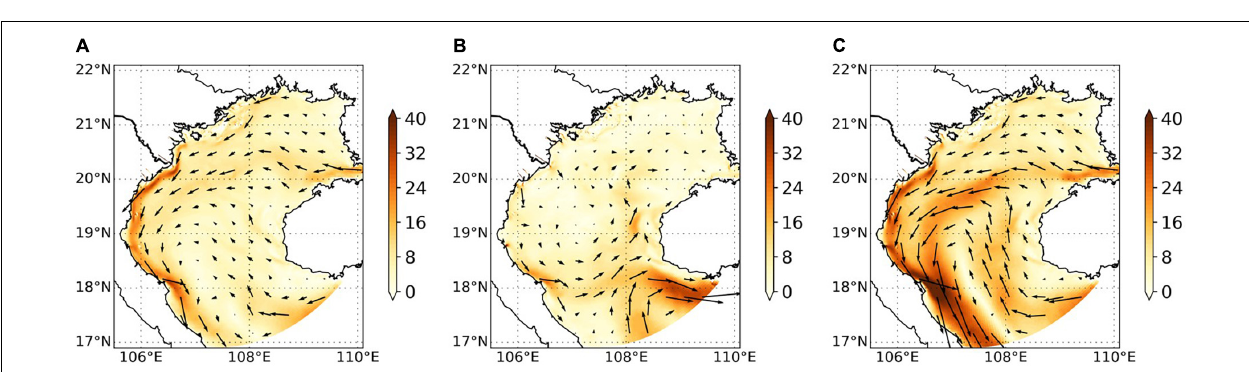
FIGURE 4 | (A,B) The first baroclinic Rossby radius of deformation (km), over the period 2011 – 2016, computed from the temperature and salinity profiles averaged from April to September (A) and October to March (B) . Contour lines indicate the bathymetry. Star shows the location of Bach Long Vi island. Note: Different color bar scales.